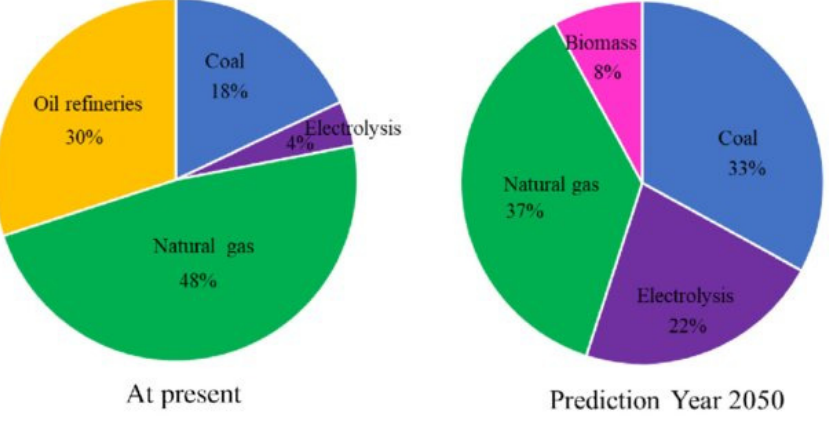
Figure 7. Chart of hydrogen production from different resources. Reprinted with permission [37]. Table 3. Comparison of three methods of hydrogen production from natural gas. Reprinted with permission [34].